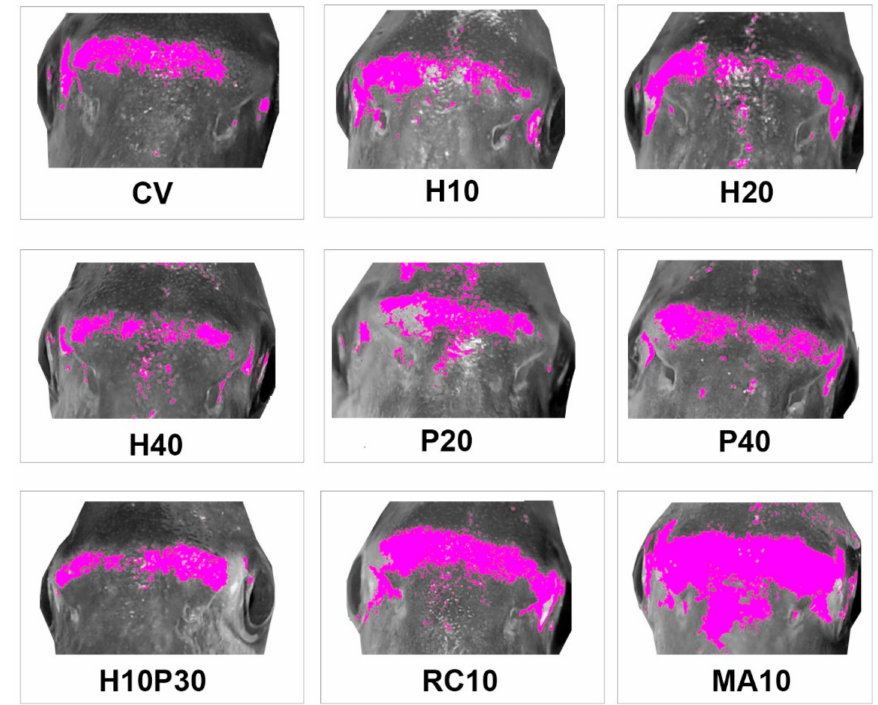
Figure 1. Average frontal profile patterns of pigmentation in gilthead seabream fed with experimental diets. Mean images for each treatment. Yellow pixels have been plotted in magenta to be more evident. CV: vegetable control; H: Hermetia illucens ; P: poultry by-product; RC: red swamp crayfish; MA: microalgae dried biomass.